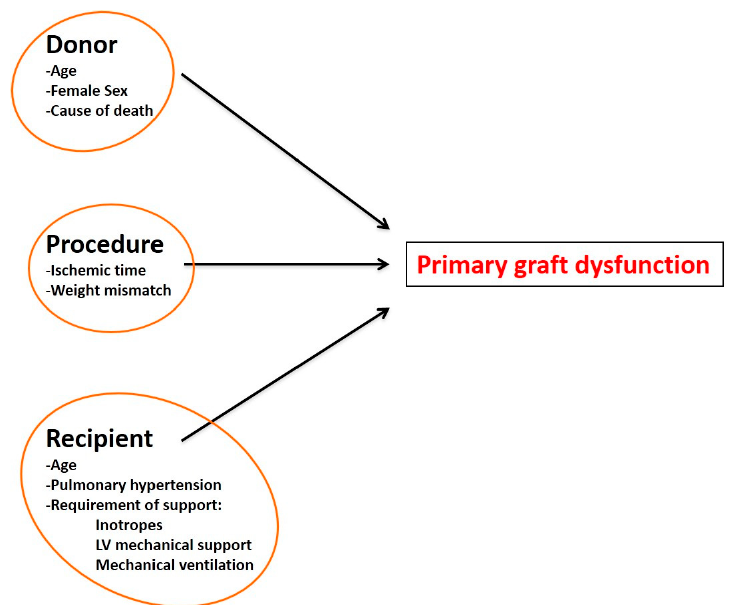
Figure 6. Risk factors for primary graft dysfunction. Donor characteristics, variables linked to the transplantation procedure, the characteristics and the post-transplant care of the recipient are among the risk factors associated with primary graft dysfunction (PGD).